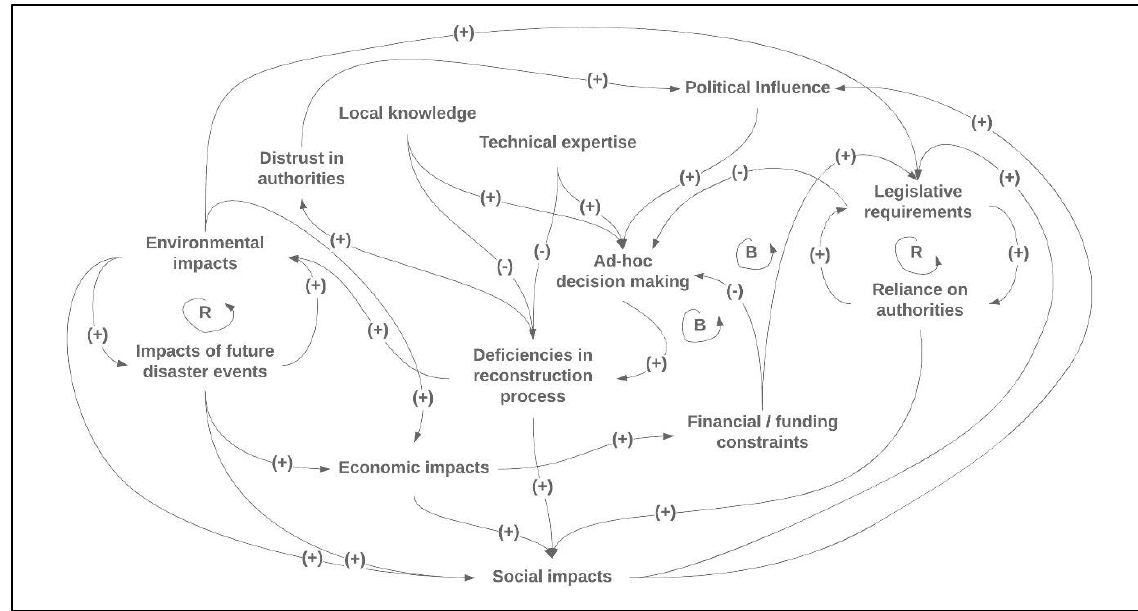
Figure 1. Causal loop diagram of PDR process of transport